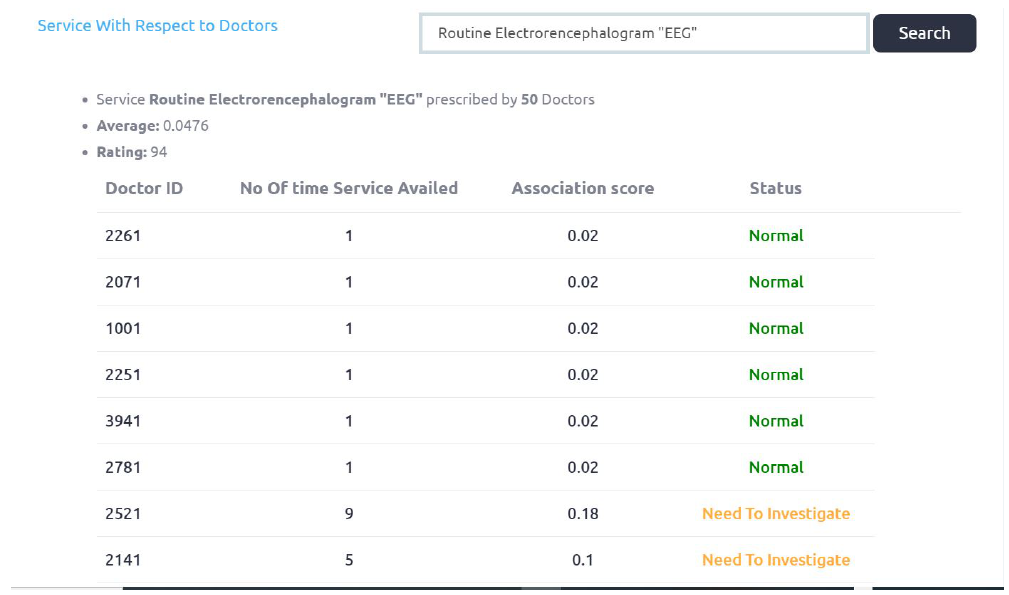
Figure 10. Service with respect to doctor association